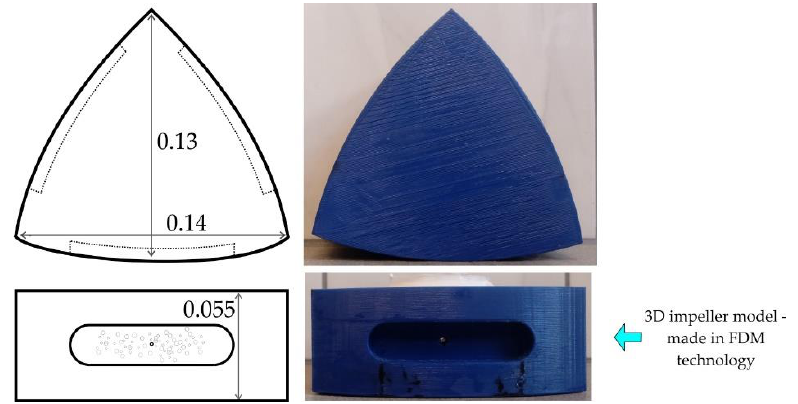
Figure 2. Schematic diagram of the analyzed impeller with its main dimensions, m.